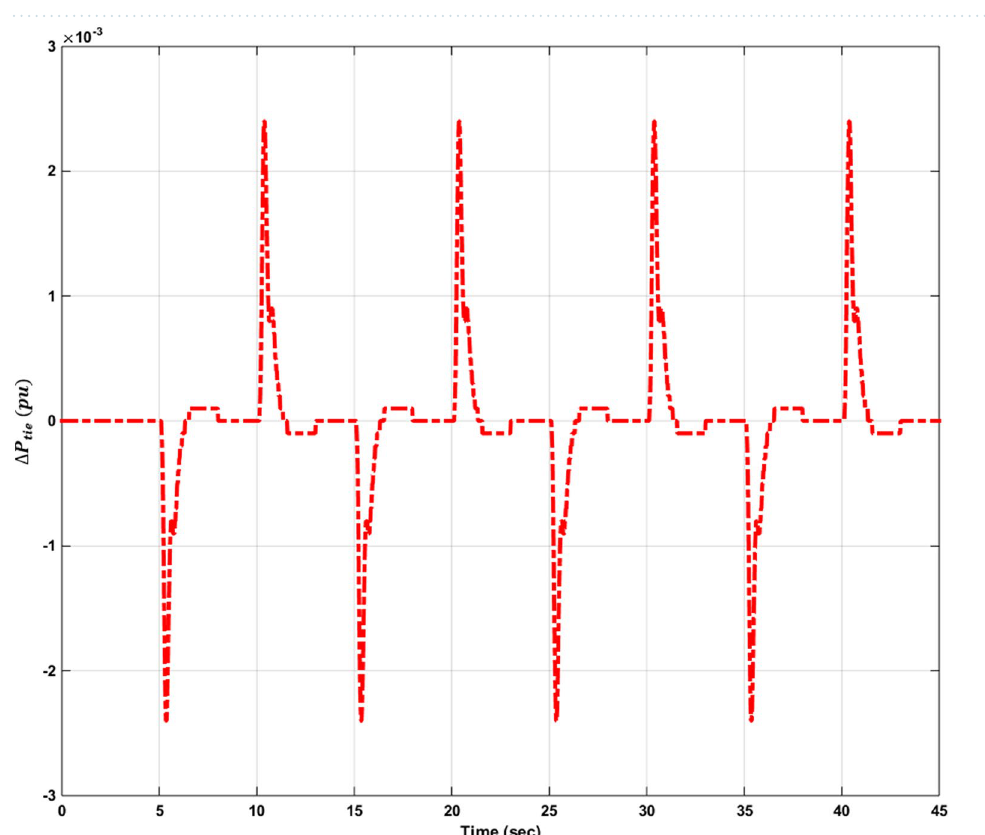
Figure 17. Tie-line power deviation result in both areas with simultaneous